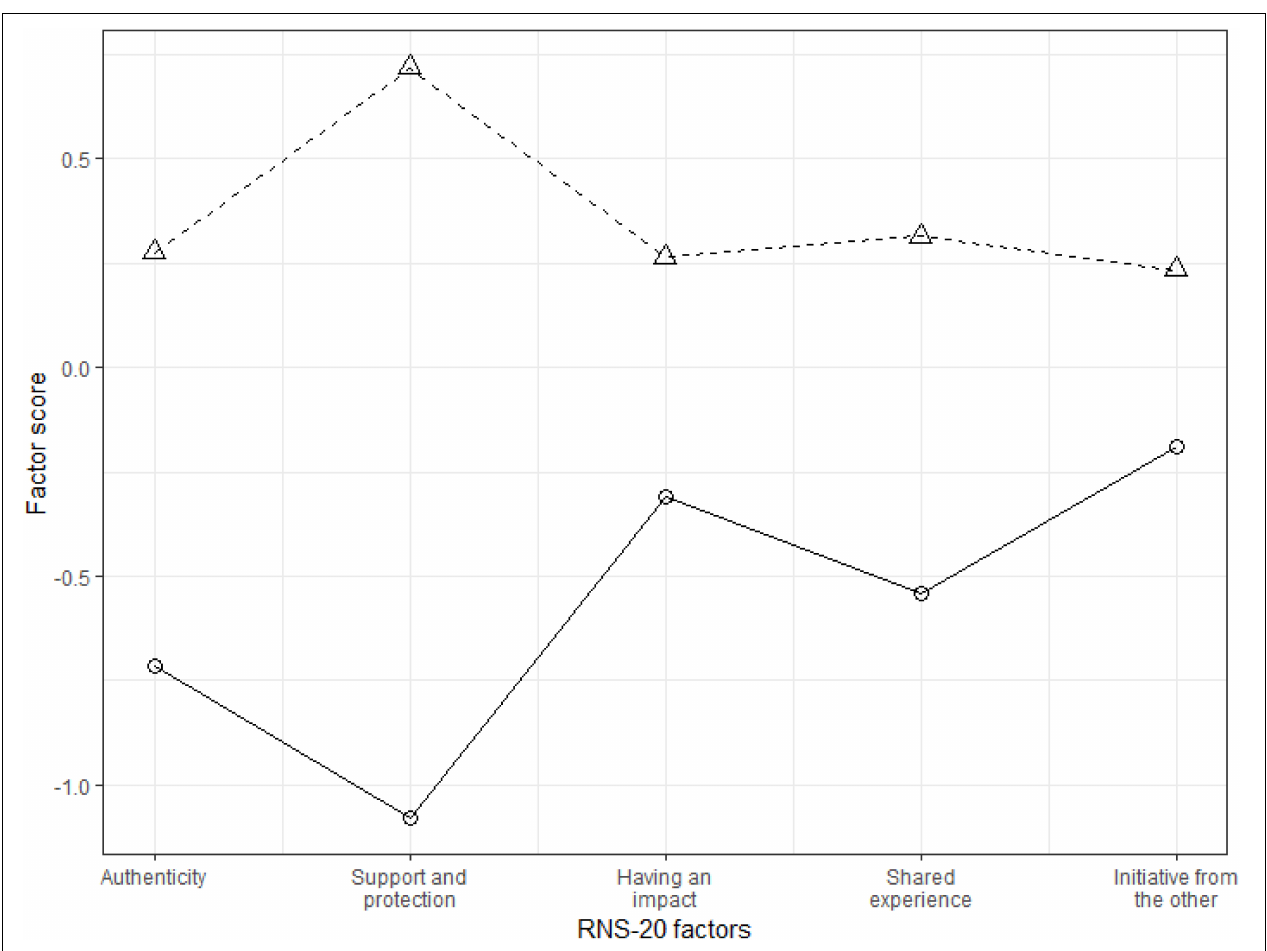
FIGURE 1 | Clusters based on the satisfaction of relational